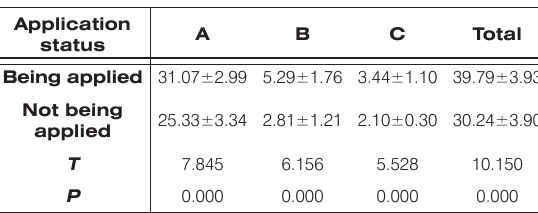
Table 1. Scores of the various dimensions in the evaluation of the clinical nursing studies